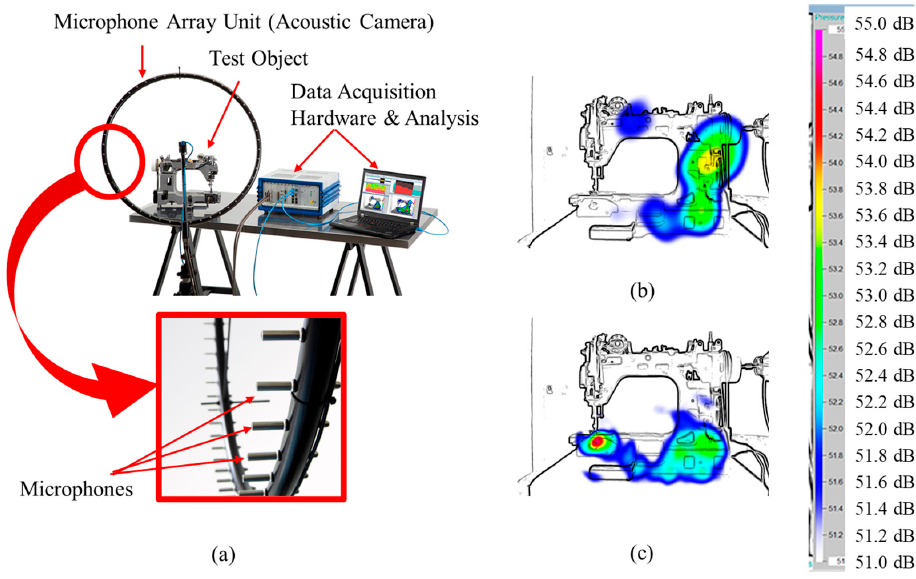
Figure 17. Acoustic camera for fault detection based on variation in emitted sound ( a ) Acoustic camera setup ( b ) test object without a fault ( c ) test object with a fault